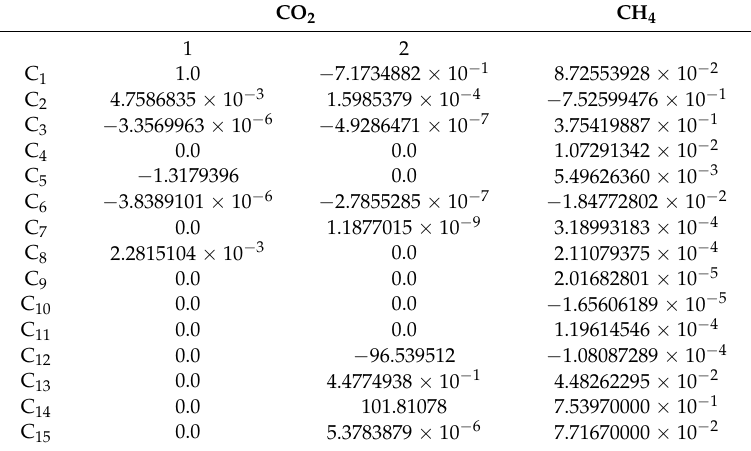
Table 2. Parameters of Equations (6) and (7) (Duan et al. [22] for CH 4 and Duan et al. for CO 2 [22,24]. CO 2 CH